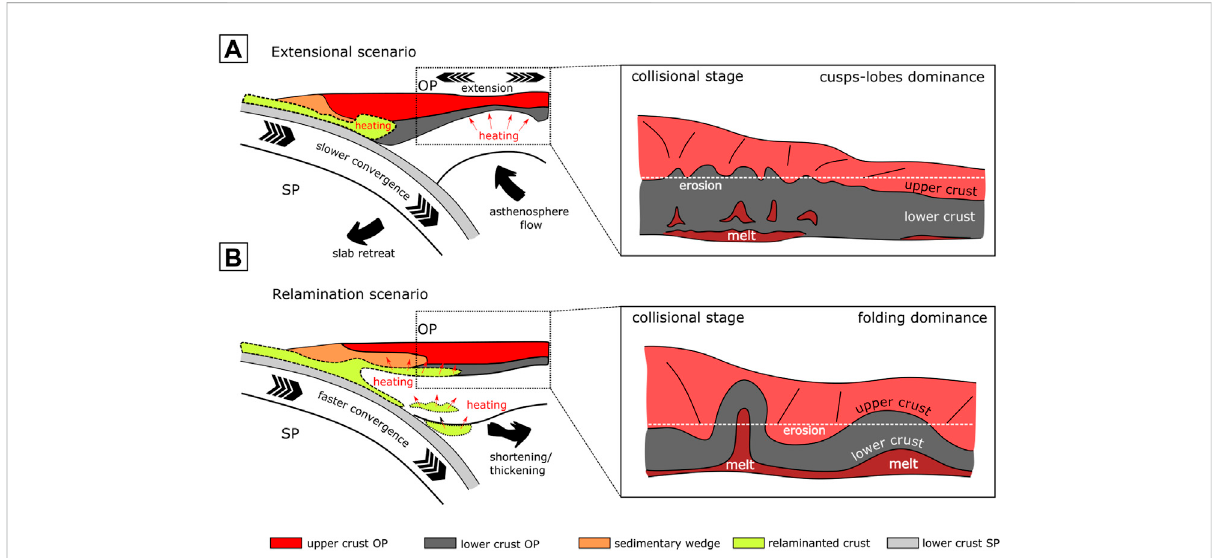
FIGURE 1 Examples of different subduction scenarios leading to building of hot orogens. (A) If the subducting plate (SP) is slower with dominance of roll- back, extension and crustal thinning occur and heat fl ux from the mantle soften the overriding plate ’ s (OP) crust. This slower scenario might lead to distributed heating without the development of a sharp detachment horizon. Thus the dominant style of bulk deformation is homogeneous thickening with smaller localized areas of melting rather than crustal-scale buckling. Faster convergence and a weak overriding plate (B) are assumptions for intra-crustal relamination (e.g., Maierová et al., 2018). The radiogenic heat production of the relaminant supports additional weakening of the lowermost crust and melting which is a good assumption for the detachment folding of the lower crust during late stage of